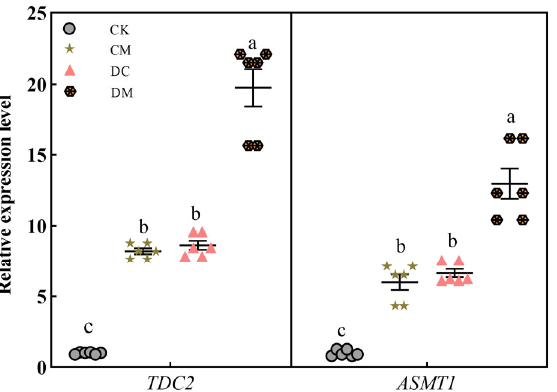
Figure 8. Effect of exogenous melatonin on melatonin synthetase gene expression levels under drought stress.